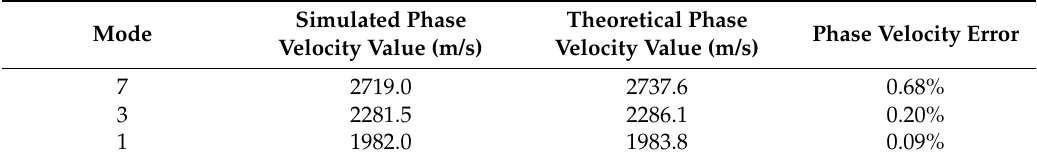
Table 4. Phase velocities of modes.